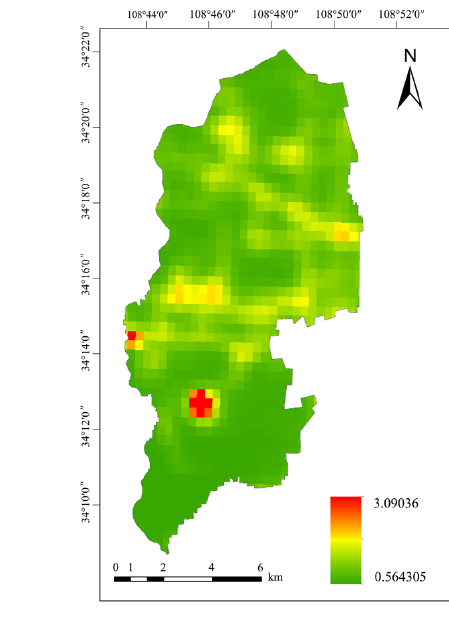
Figure 7. Evaluation of ecological demand intensity. ( a ) The evaluation result of the importance of ecological demand intensity; ( b ) land analysis.